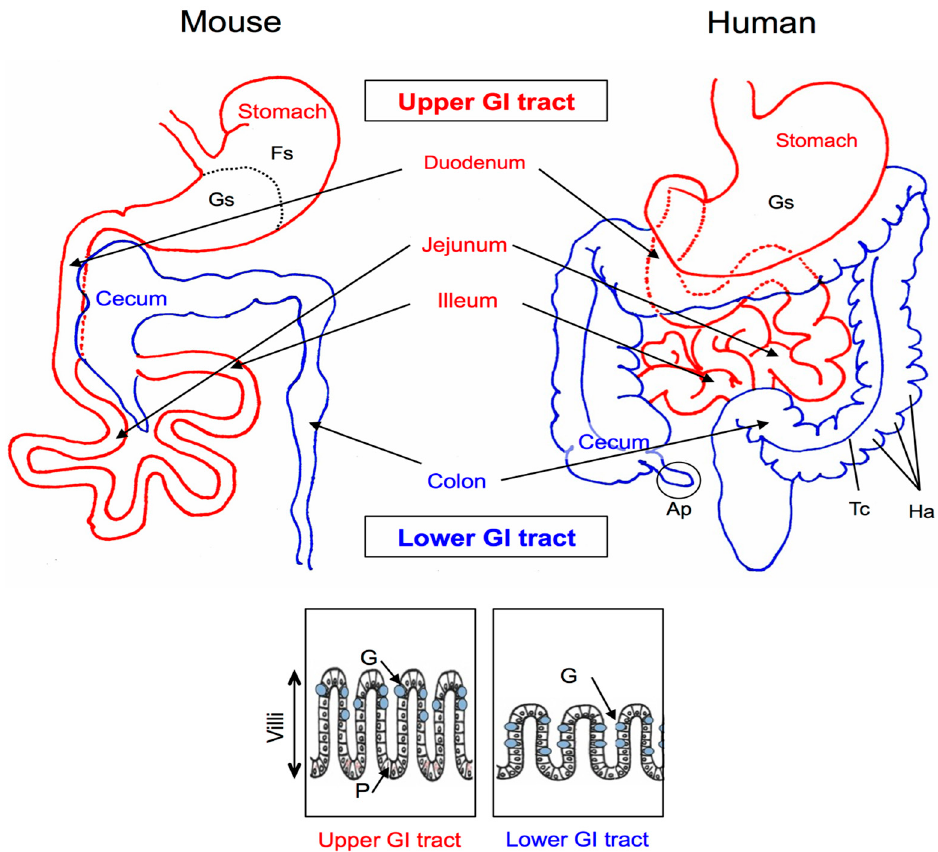
Figure 1. Mouse and human abdominal anatomy. The gastrointestinal (GI) tract is divided into two regions: the upper (red) and the lower (blue) GI tract. The rectangles show schematic models of the villi of the upper and lower GI tracts. G, goblet cells; P, Paneth cells; Fs, forestomach; Gs, glandular stomach; Ap, appendix; Tc, taenia coli; Ha, haustra.